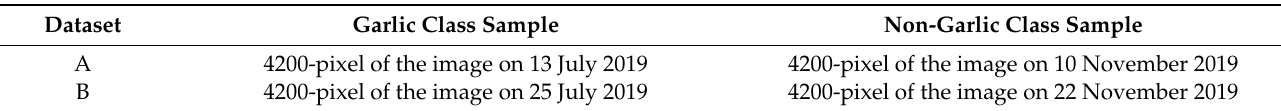
Table 4. Image composition for each dataset.